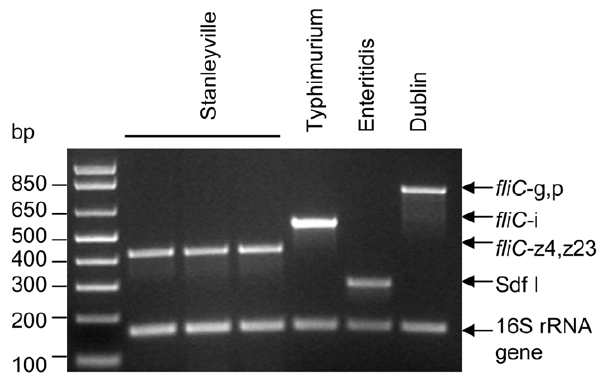
Figure 4. Detection of Salmonella Stanleyville. Amplification of fliC from 3 Salmonella Stanleyville strains from Mali and Salmonella Typhimurium 81.23500, Salmonella Enteritidis CVD SE and Salmonella Dublin 06-0707 following the addition of Hz4,z23 primers to the fliC -i/ fliC -gp/Sdf I multiplex PCR mix.